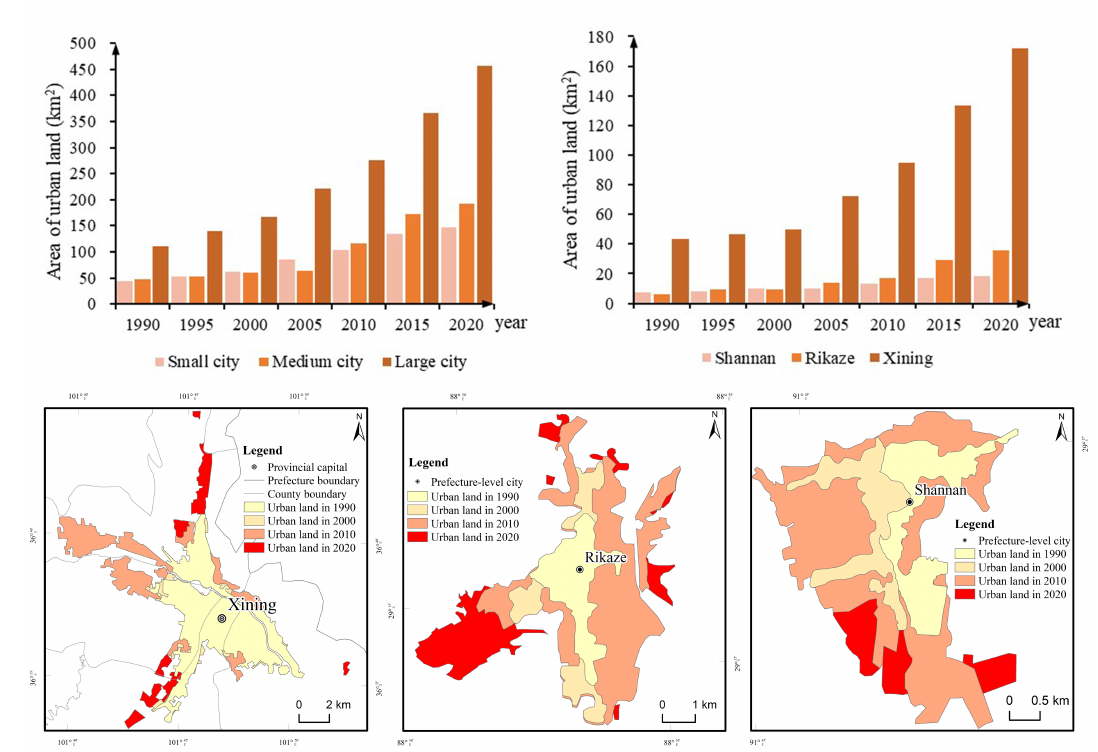
Figure 5. Spatial distribution of urban expansion in urban